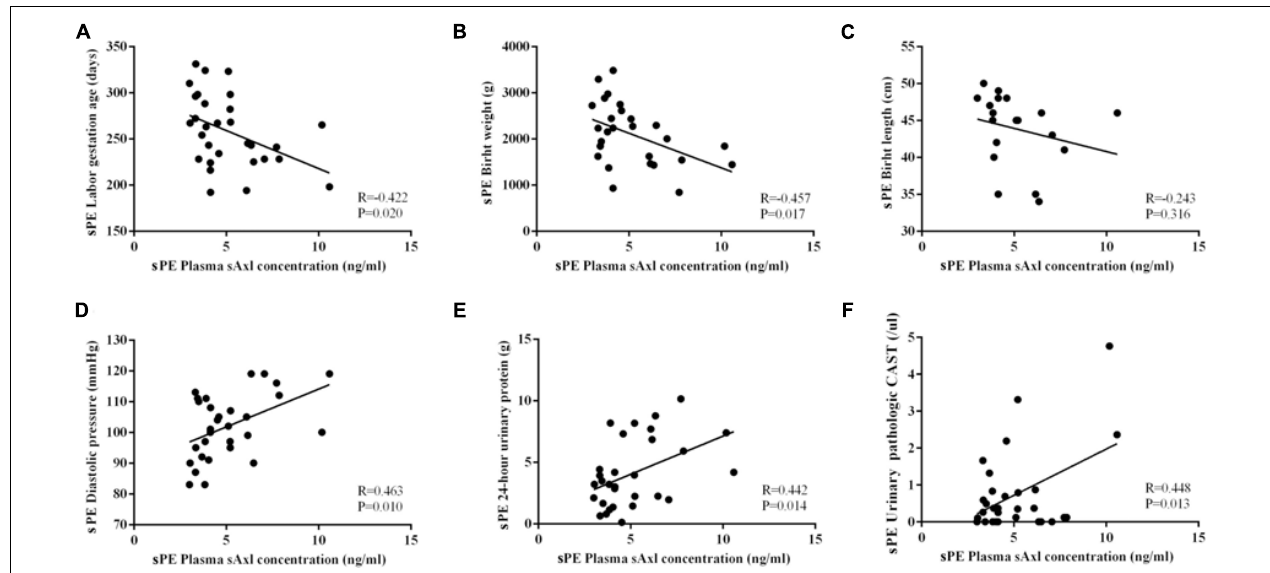
FIGURE 2 | Correlation analysis of the plasma sAxl level and clinical indicators in preeclampsia with severe features (sPE). (A) Gestational age. (B,C) Birth weight and length. (D) Diastolic blood pressure. (E) 24-h urinary protein. (F) Urine pathologic CAST. n = 30 per group.